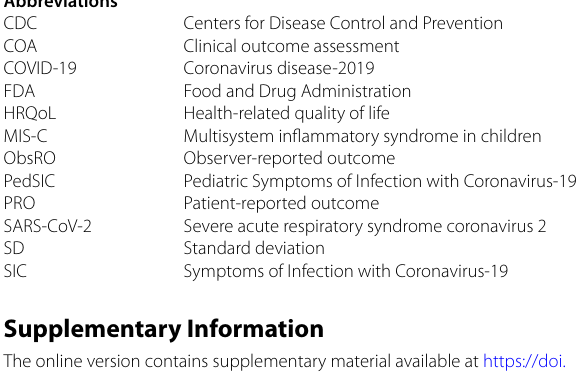
Additional file 1: Table S1 : Lexile Framework Reading Level Assess‑ ment of SIC Items. Table S2 : Representative Descriptions of Adolescent Feedback of SIC Items. Table S3 . Representative Descriptions of Caregiver Feedback of PedSIC